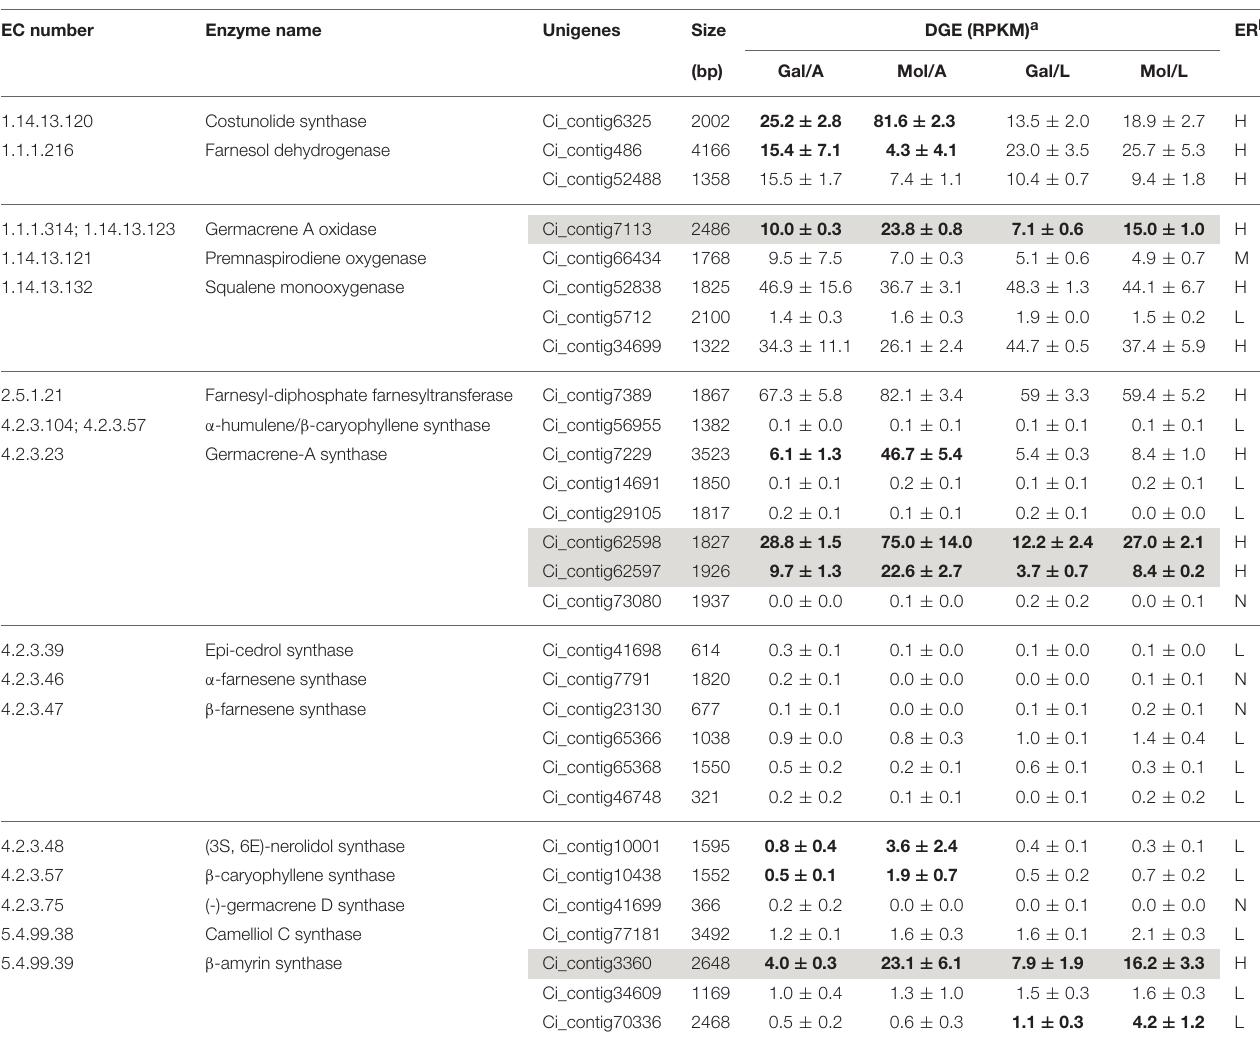
TABLE 6 | Unigenes annotated in the sesquiterpenoid and triterpenoid pathway and DGE